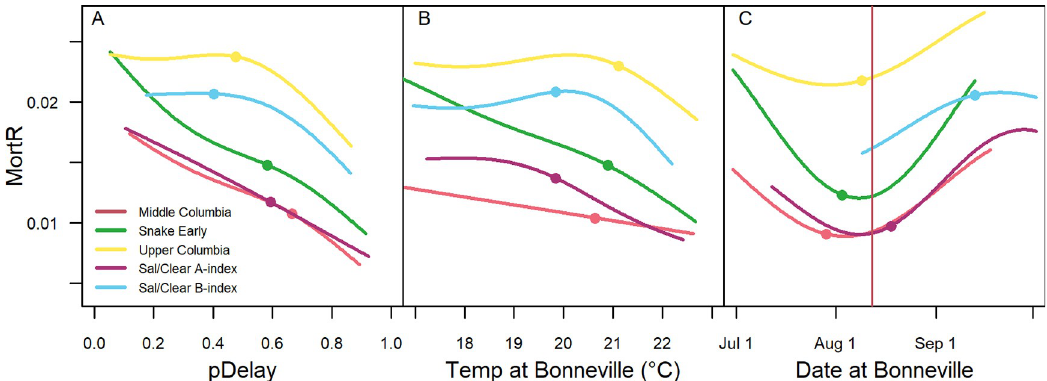
Fig 8. Mortality rate relationships. Modeled relationships between estimated daily mortality rates ( MortR ) and predicted probability of delay ( pDelay ) (A), temperature upon arrival at Bonneville Dam (B), and arrival date at Bonneville Dam (C). Median values by population group are shown by points. All lines were fit with GAM smoothers and demonstrated P -values < 0.005. Vertical red line represents date of peak temperatures averaged across study years (C).